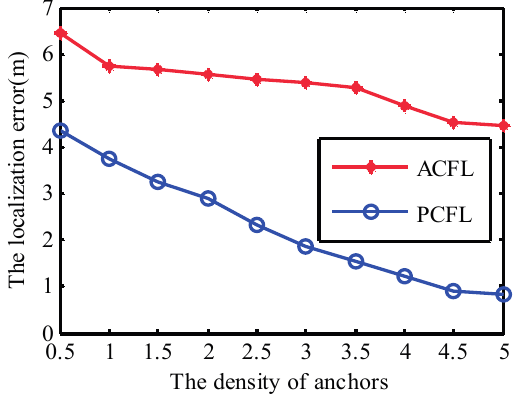
Figure 7. The density of